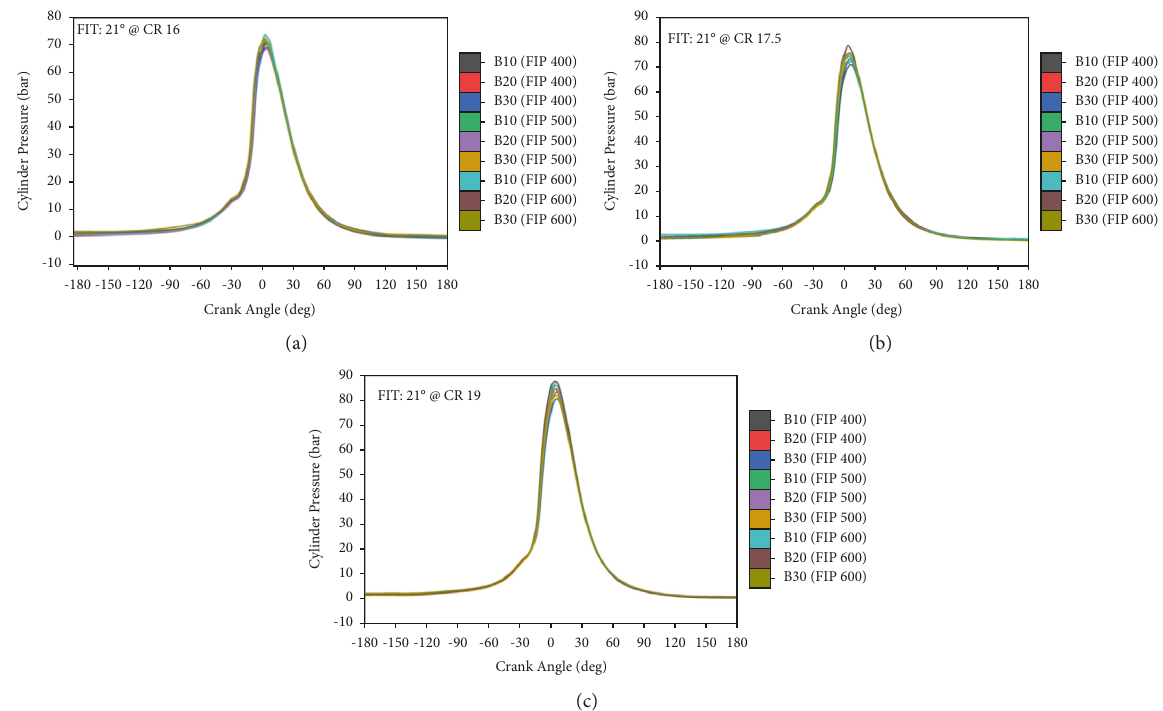
Figure 12: (a) Crank angle vs cylinder pressure at CR 16 and different FIPs. (b) Crank angle vs cylinder pressure at CR 17.5 and different FIPs. (c) Crank angle vs cylinder pressure at CR 19 and different